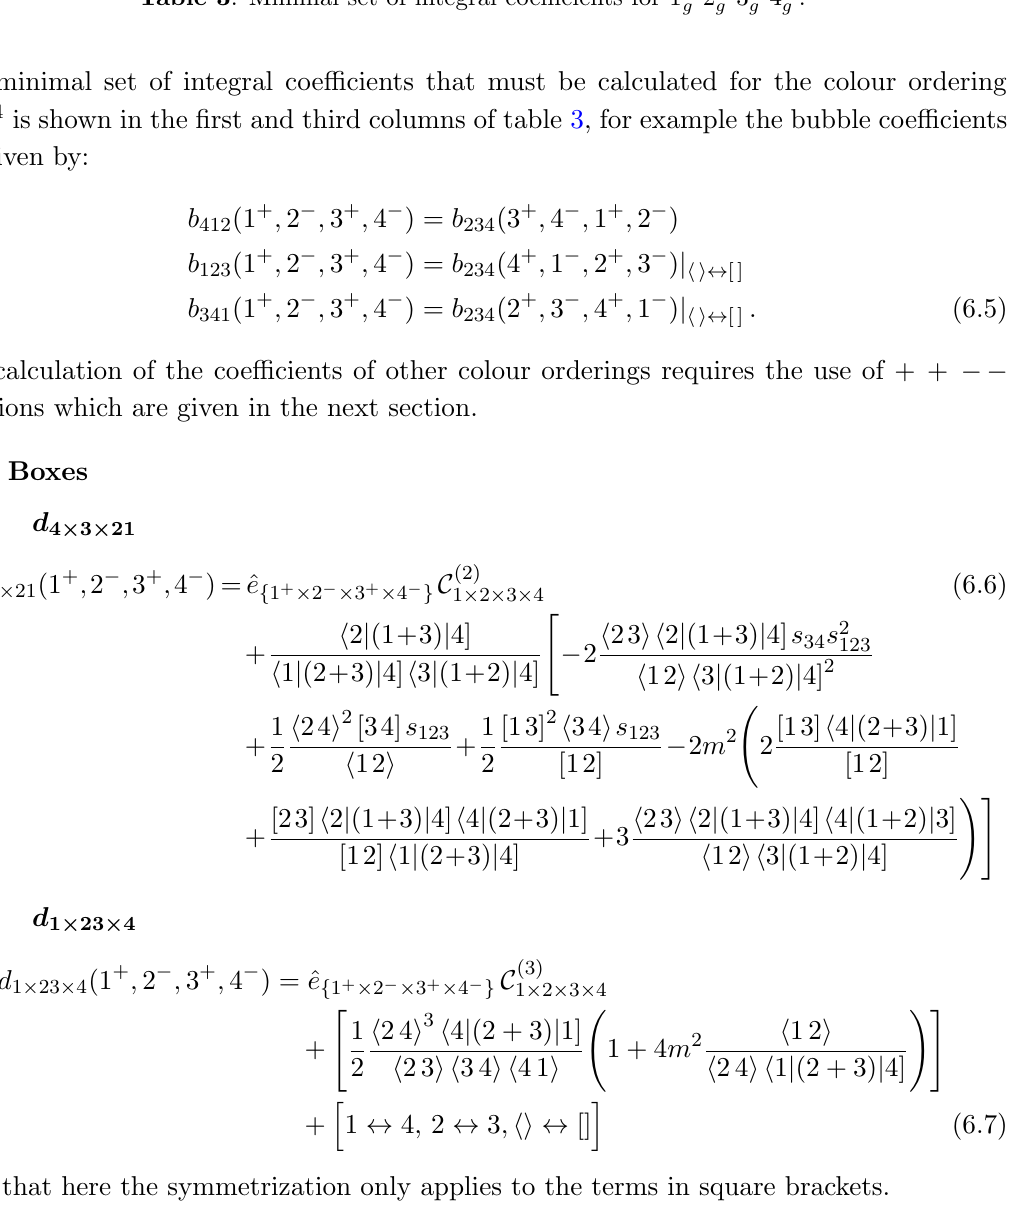
Table 3 . Minimal set of integral coe(cid:14)cients for 1 +